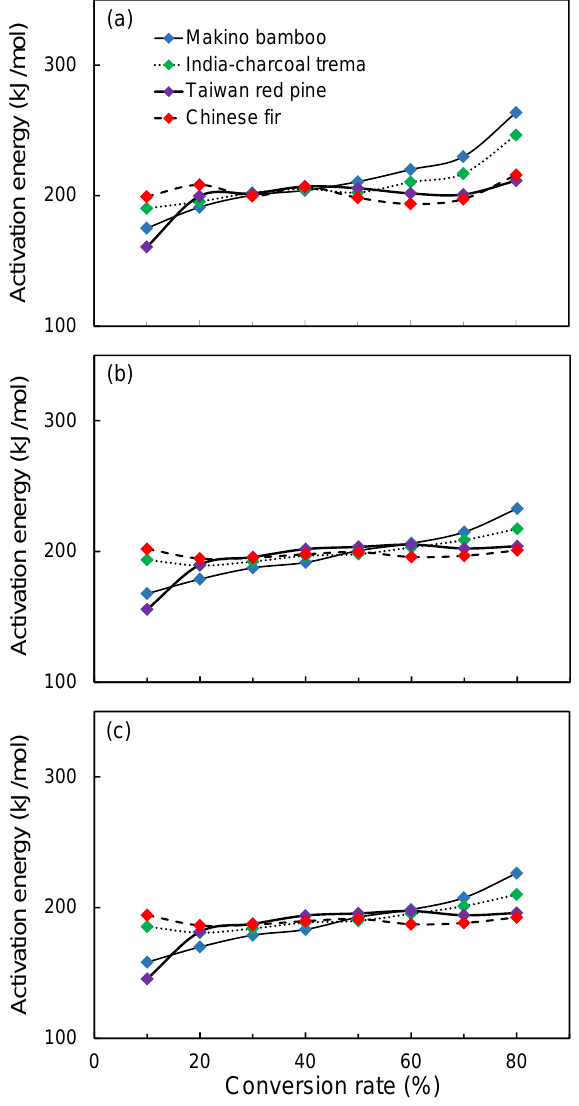
Figure 5. Typical isoconversional plots using the Friedman method ( a ); Flynn-Wall-Ozawa method ( b ); and Modified Coats-Redfern method ( c ) for Chinese fir.